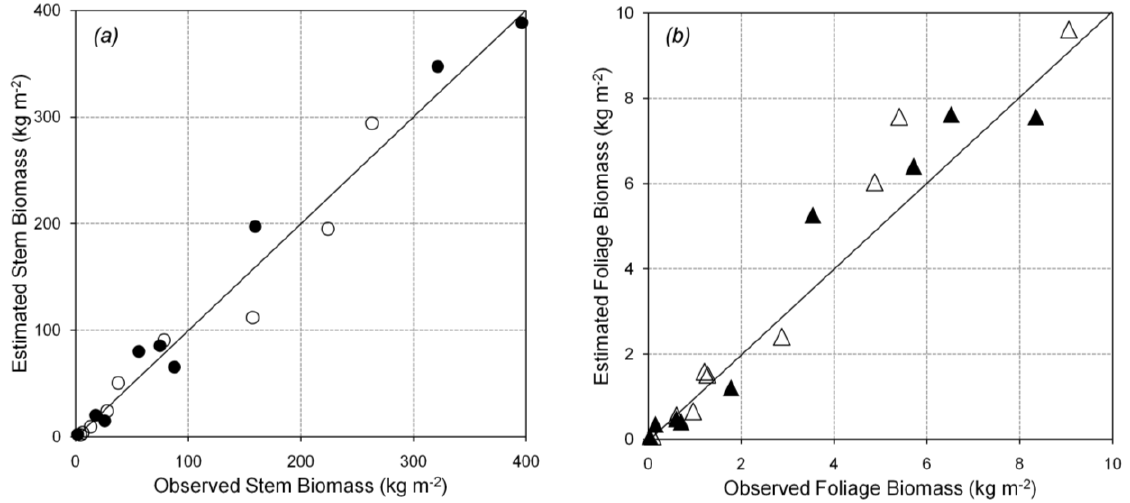
Figure 6. Validation of (a) estimated stem biomass versus observed stem biomass at Hitsujigaoka (open circle) and Takayama (solid circle); and (b) estimated foliage biomass versus observed foliage biomass at Hitsujigaoka (open triangle) and Takayama (solid triangle). The estimated values equal the observed values.